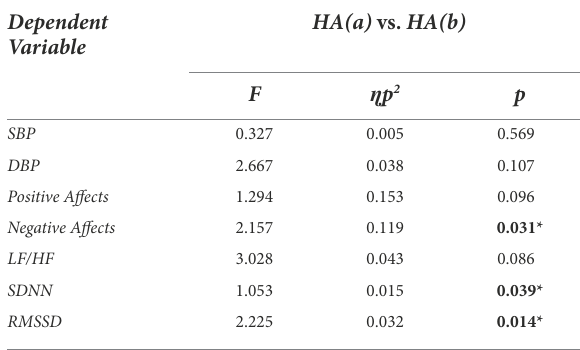
TABLE 5 The influence of the presence or absence of green plants in horticultural activities on the variation of the dependent variable.